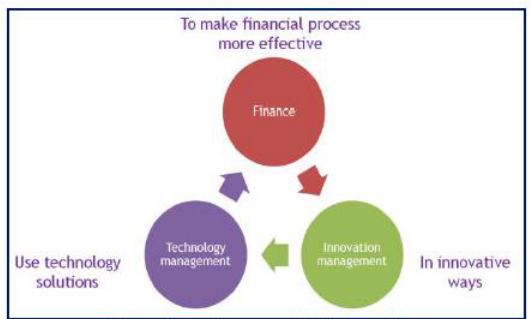
Fig. 4. FinTech – Cross Disciplinary nature 4 India and 5G Services in